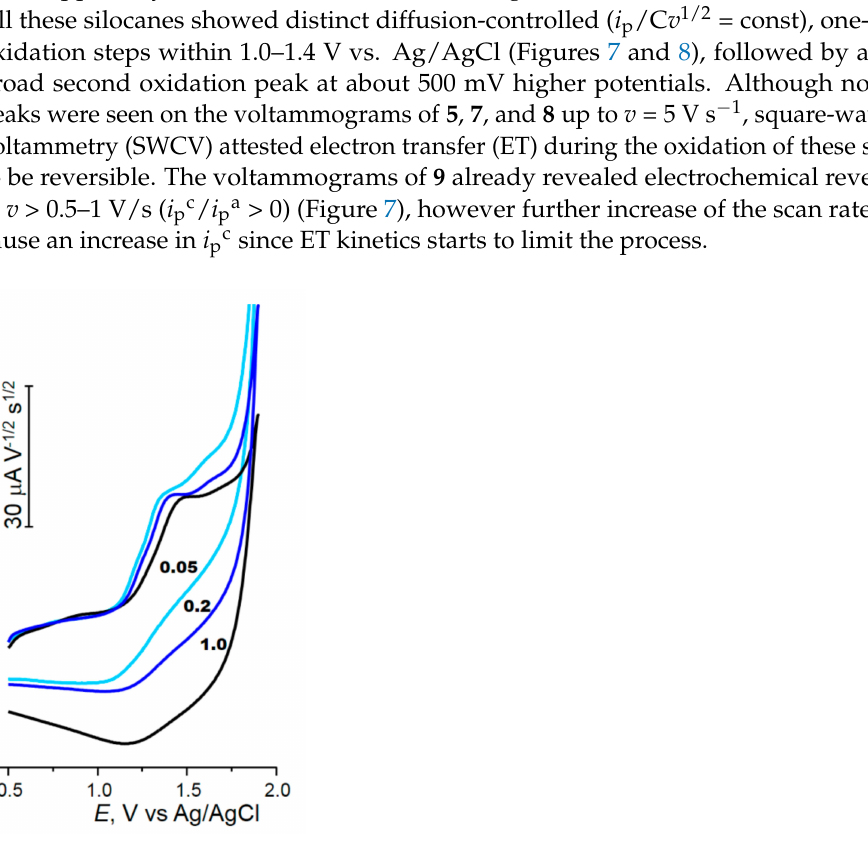
Figure 7. Scan rate-normalized voltammograms of oxidation of 9 at a glassy carbon (GC) electrode in AN/0.1 M Bu 4 NPF 6 . Numbers: scan rate v in V s − 1